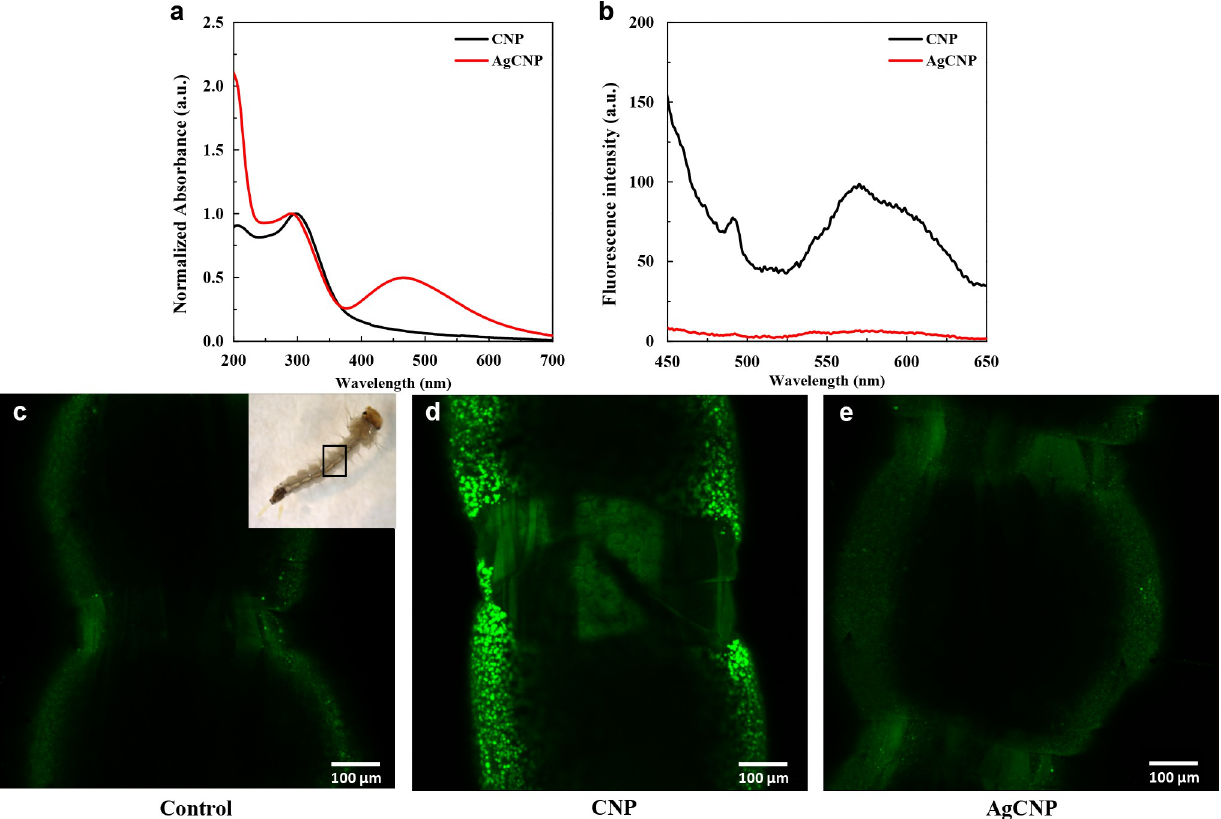
Fig 5. Optical properties of nanoceria. ( a ) Absorbance spectra and ( b ) emission spectra of CNP (black line) and AgCNP (red line) depicting λ max- absorption of CNP at 300nm and λ max-amission at 570nm. Doping with Ag quenches the emission of CNP, though AgCNP show absorbance at 466nm in addition to the 300nm peak. ( c-e ) Confocal fluorescence microscopy of larvae exposed to nanoceria. ( c ) Gut of control larva (No nanoceria), ( d ) gut of larva treated with CNPs and ( e ) gut of larva treated with AgCNPs. Bright fluorescence is seen in the larva treated with CNPs; objective lens: 10 × , excitation laser: